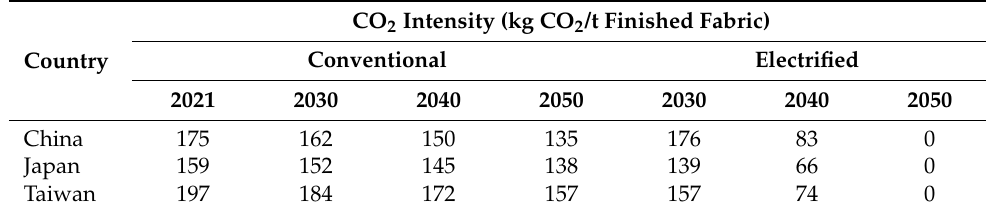
Table 14. The CO 2 intensity of the conventional and electrified finishing (pad-dry-cure) process.